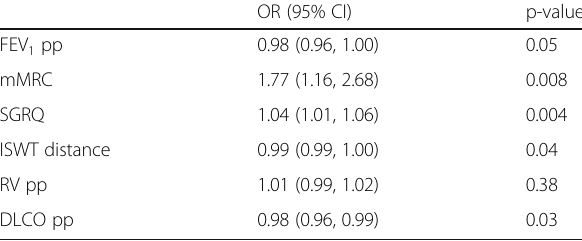
Table 4 Logistic regression analyses with COPD severity at baseline as independent variable and sleep disturbance at 2- year follow-up as dependent variable OR (95%